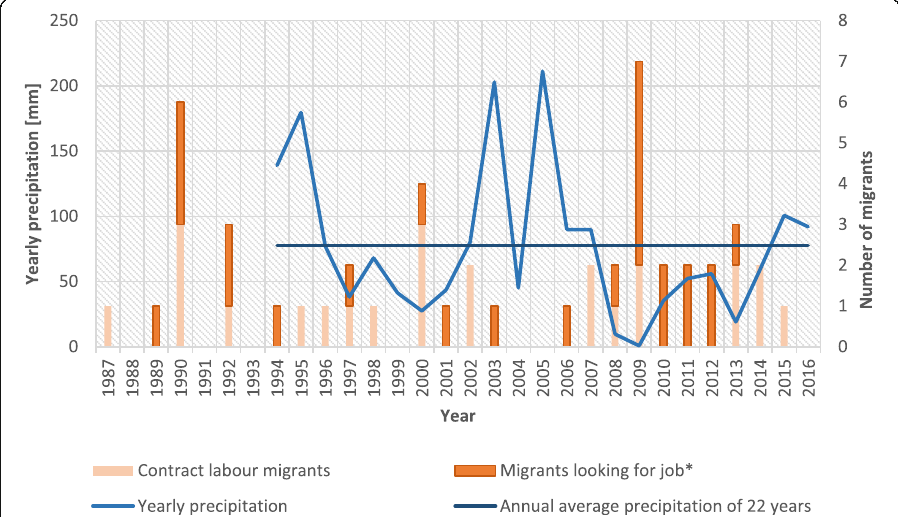
Fig. 2 Relationship between the number of migrants and yearly precipitation. Source: Survey (data for 56 economic migrants) and NOAA GSOD data (precipitation). * “ Migrants looking for job ” response